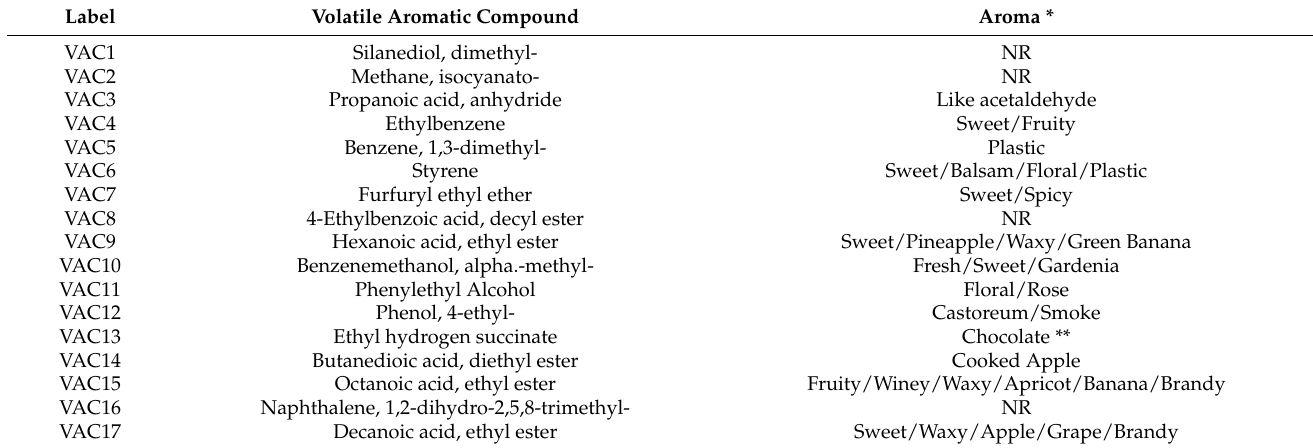
Table 3. Volatile aromatic compounds identified by GC–MS for wine samples.